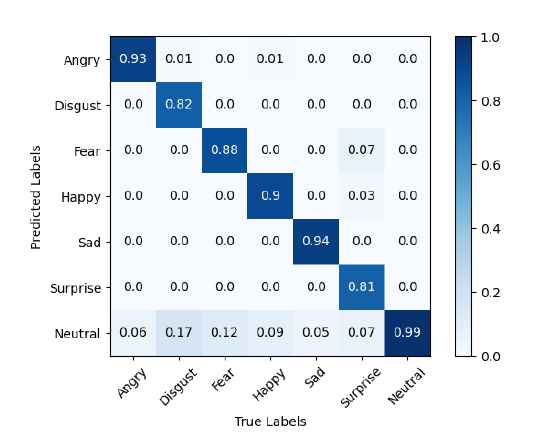
Figure 9. The confusion matrix of FERDERnet_X without ABR module when trained on the on-road driver facial expression dataset. Table 5. Ablative evaluation with and without (w/o) the ABR module of FERDERnet. Model